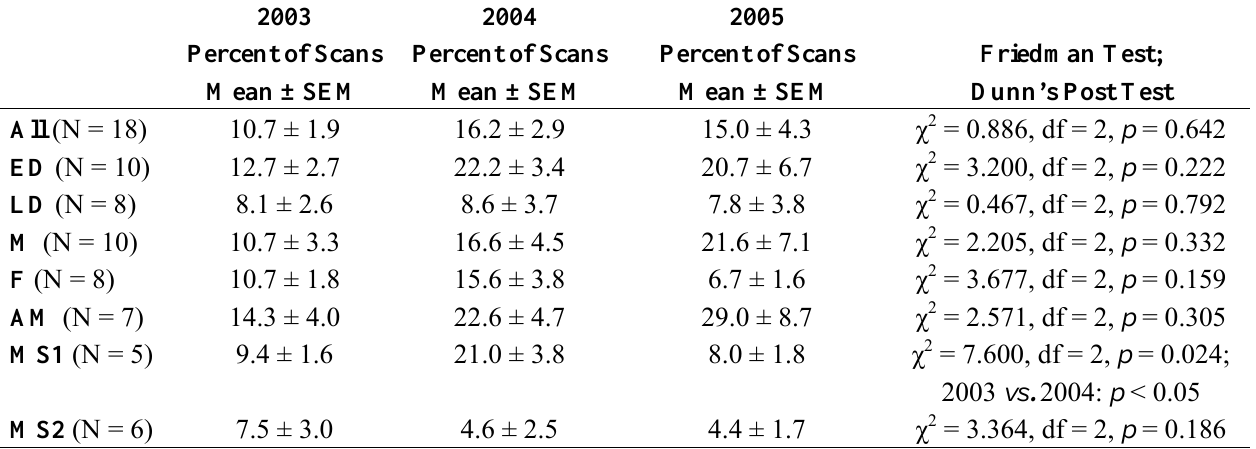
Table 2. Comparison of the mean percent of scans spent on overall abnormal behavior over the three sample periods (2003 to